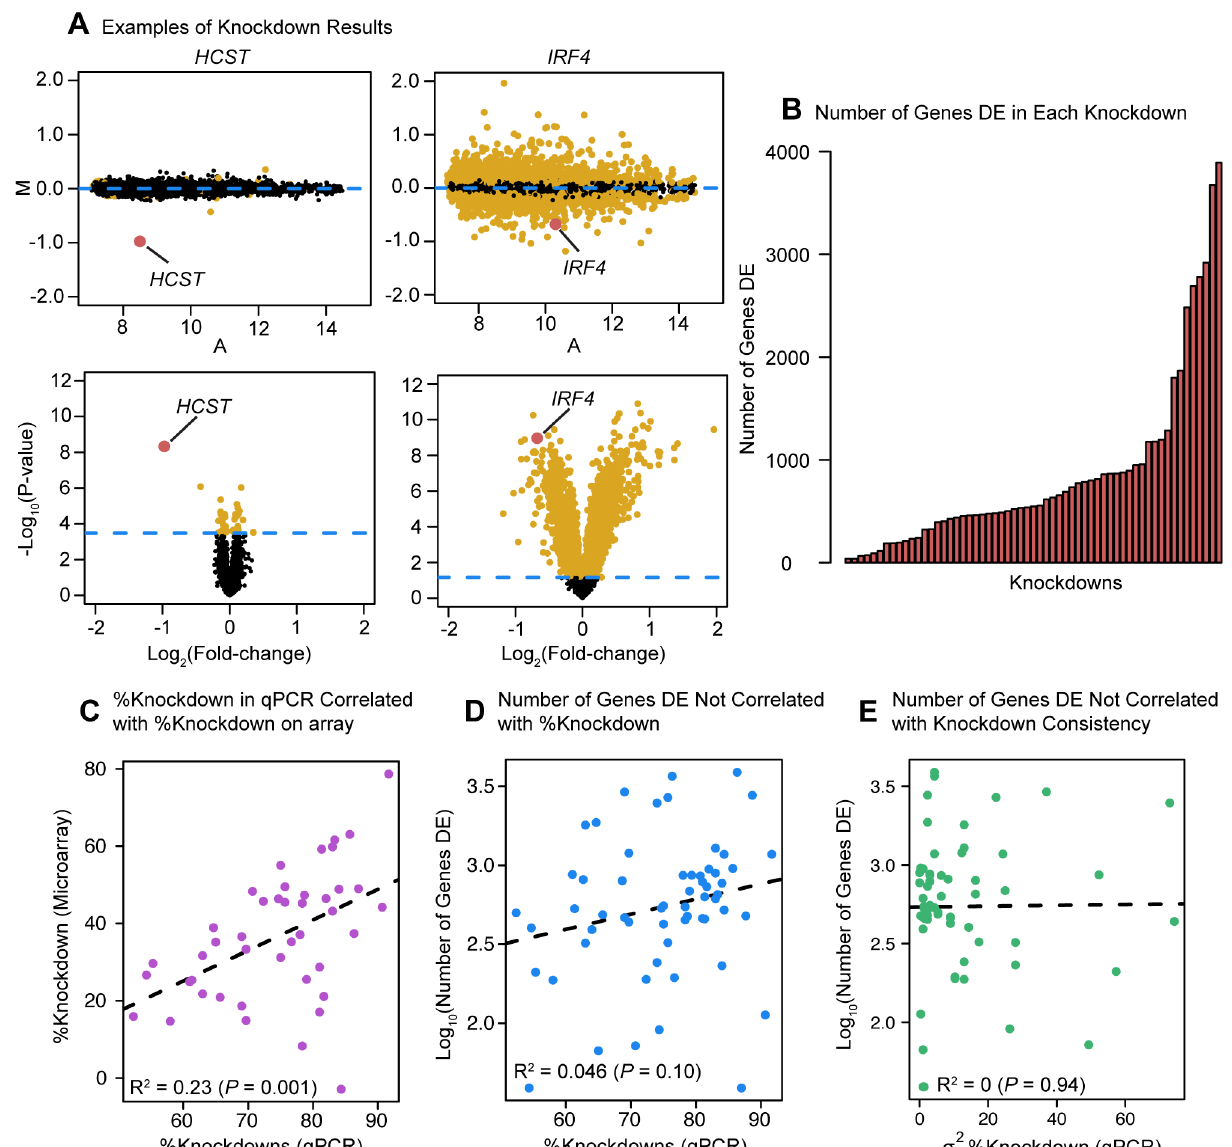
Figure 1. Differential expression analysis. (a) Examples of differential expression analysis results for the genes HCST and IRF4 . The top two panels are ‘MA plots’ of the mean Log 2 (expression level) between the knockdown arrays and the controls for each gene (x-axis) to the Log 2 (Fold- Change) between the knockdowns and controls (y-axis). Differentially expressed genes at an FDR of 5% are plotted in yellow (points 50% larger). The gene targeted by the siRNA is highlighted in red. The bottom two panels are ‘volcano plots’ of the Log 2 (Fold-Change) between the knockdowns and controls (x-axis) to the P-value for differential expression (y-axis). The dashed line marks the 5% FDR threshold. Differentially expressed genes at an FDR of 5% are plotted in yellow (points 50% larger). The red dot marks the gene targeted by the siRNA. (b) Barplot of number of differentially expressed genes in each knockdown experiment. (c) Comparison of the knockdown level measured by qPCR (RNA sample collected 48 hours post- transfection) and the knockdown level measured by microarray. (d) Comparison of the level of knockdown of the transcription factor at 48 hrs (evaluated by qPCR; x-axis) and the number of genes differentially expressed in the knockdown experiment (y-axis). (e) Comparison of the variance in knockdown efficiency between replicates for each transcription factor (evaluated by qPCR; x-axis) and the number of differentially expressed genes in the knockdown experiment (y-axis).